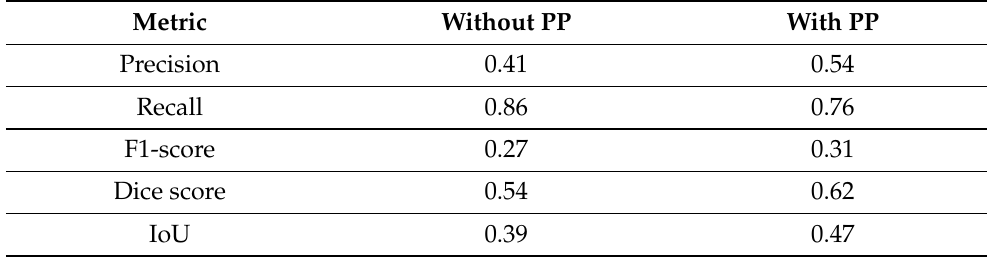
Table 1. Results on Pix2Pix validation dataset with and without